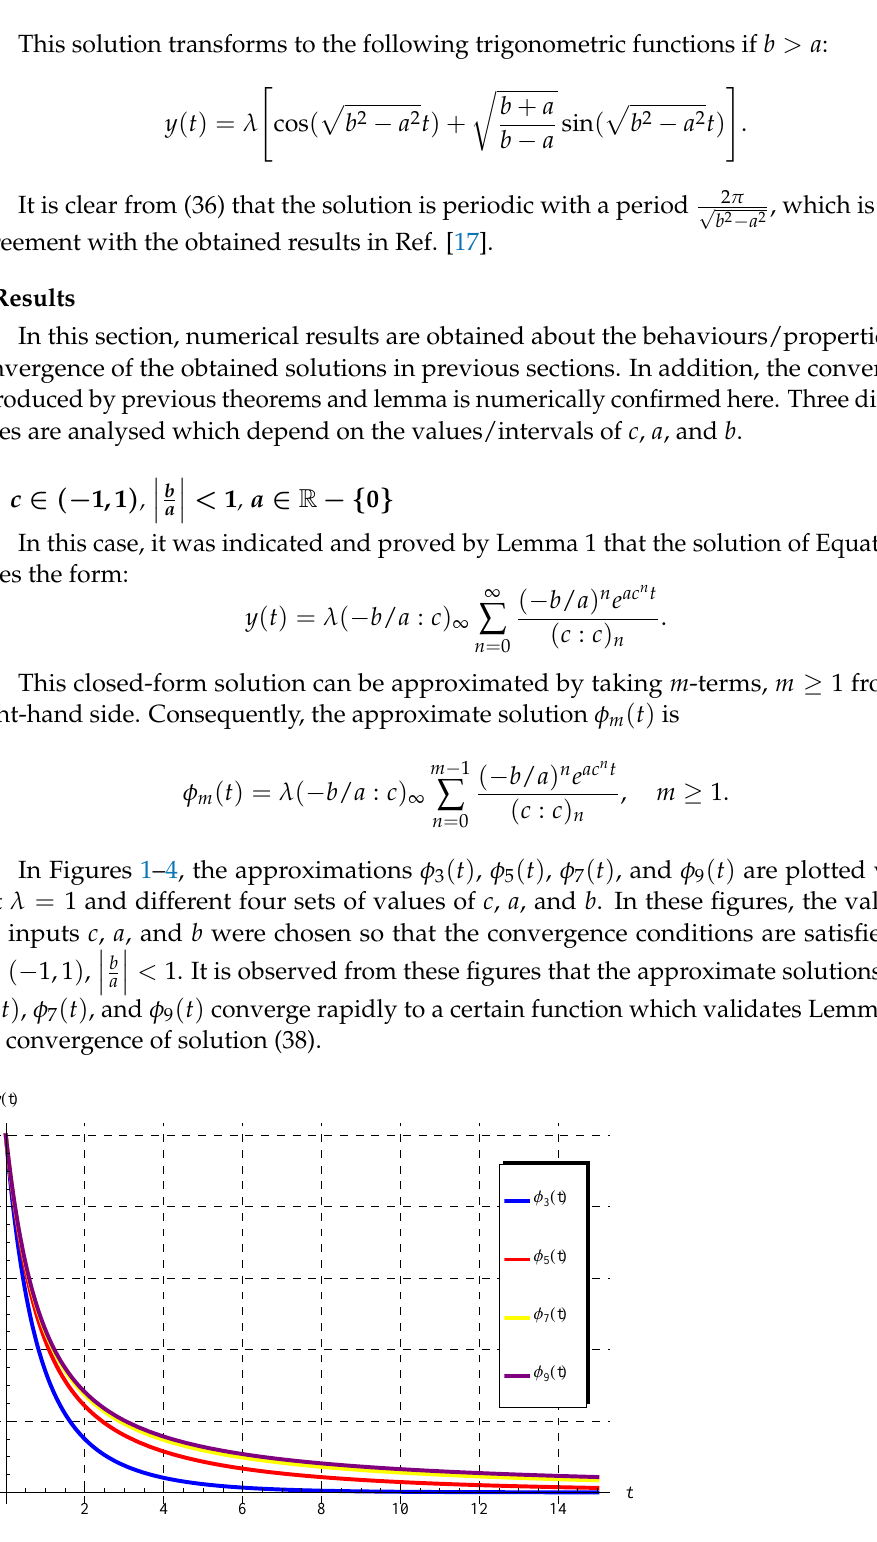
Figure 1. Plots of the approximate solutions φ m ( t ) , m = 3,5,7,9 in Equation (38) vs. t at λ = 1, c = 1 b = 1, and a = −